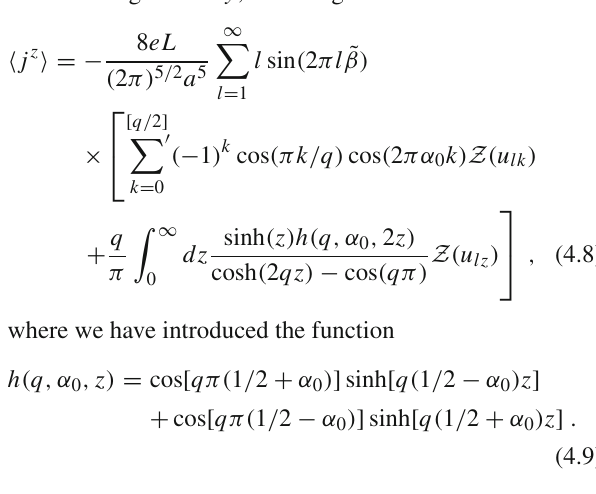
Fig. 4 The VEV of the axial current induced by the compactification in Eq. (4.12) is plotted, in units of a 5 e − 1 , for q = 2 . 5, r /w = 1 and ma =